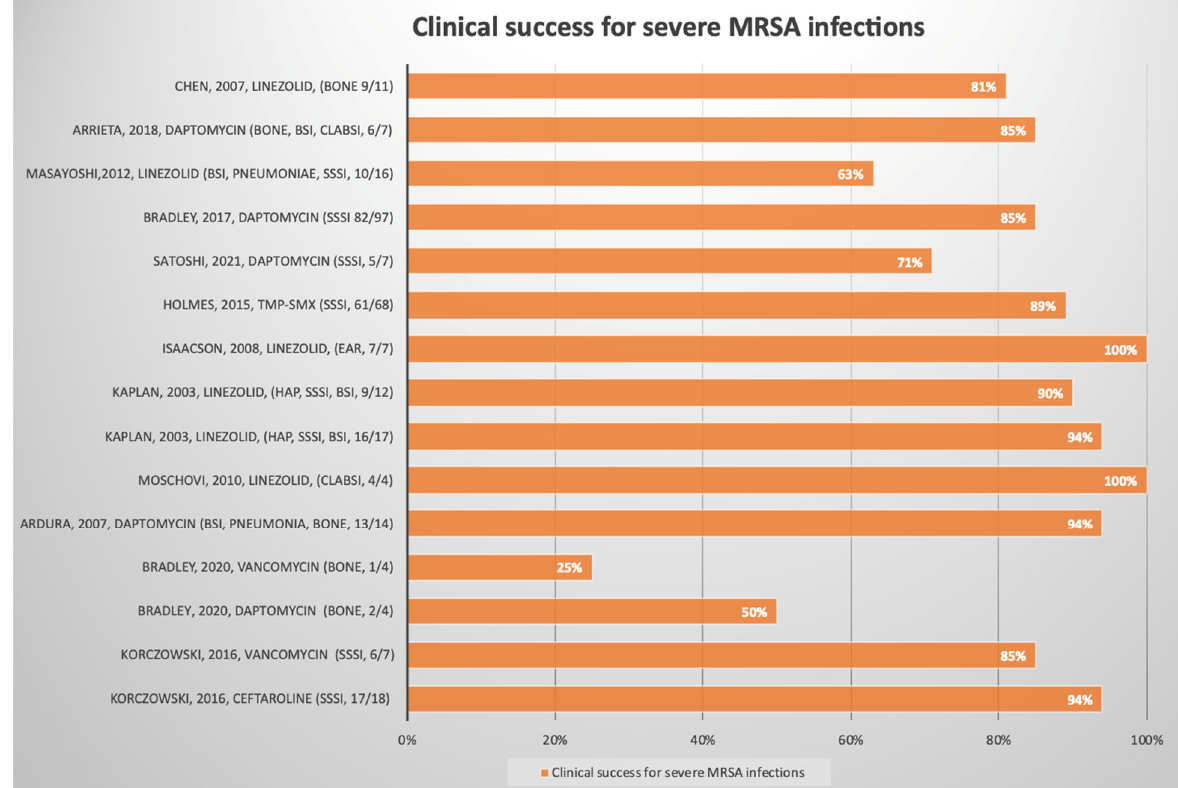
Figure 2. Results regarding the choice of treatment and clinical success for methicillin ‐ resistant Staphylococcus aureus (MRSA) infections. Clinical success was defined as complete resolution or substantial improvement of the signs and symptoms of the index infection. BSI: bloodstream infection; SSSI: skin and structure skin infections, CLABSI: central line ‐ associated bloodstream infection, HAP: hospital ‐ acquired pneumonia.